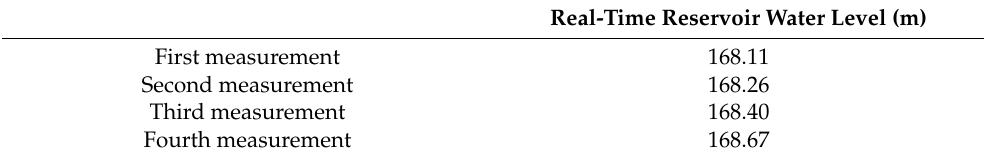
Figure 15. Field work in Baijiabao landslide. Table 3. Reservoir water levels during measurement.